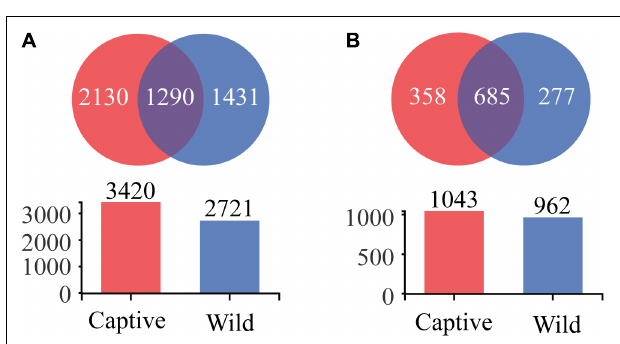
FIGURE 4 | Venn diagram of gut microbiota in Tokay gecko at the OTU (A) and genus (B)